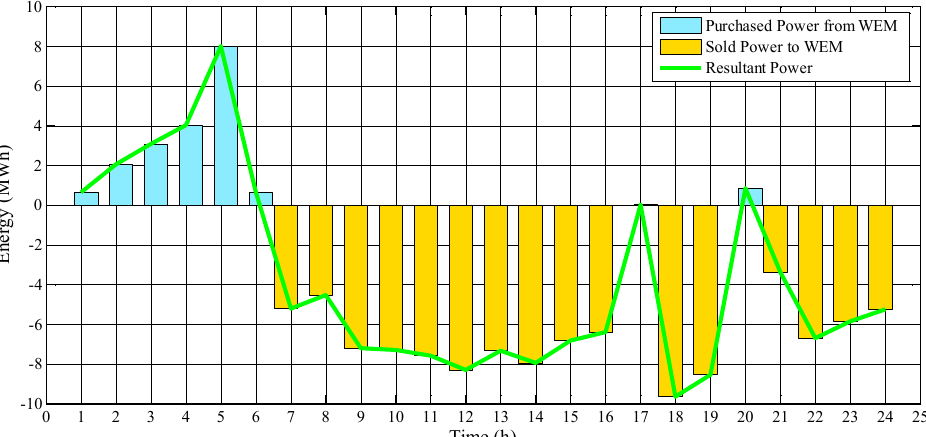
Purchased Power from WEM Sold Power to WEM